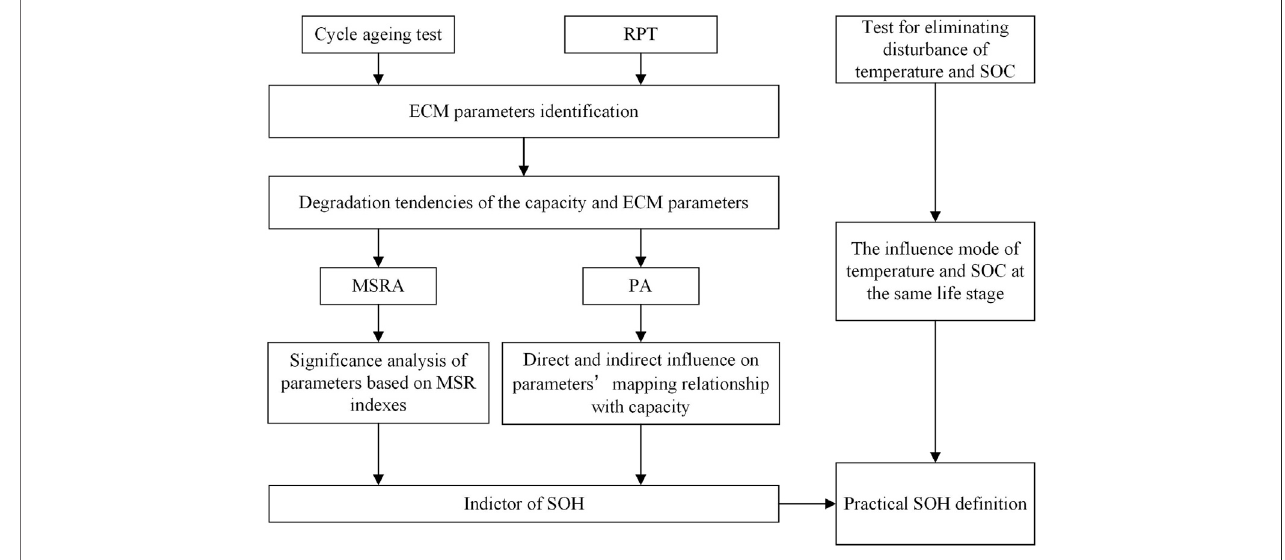
FIGURE 2 | Methodology for SOH indicator determination.